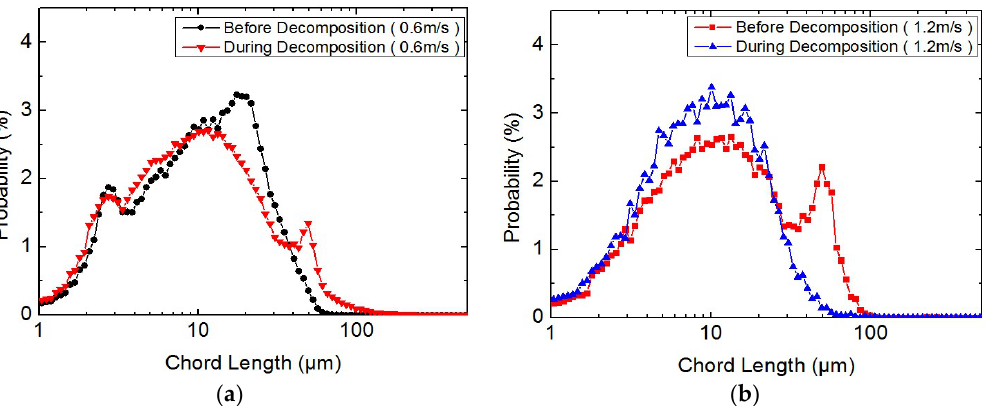
Figure 9. Influence of flow rate on chord length distribution during hydrate dissociation ( a , b ). ( a ) Influence of flow rate on chord length distribution (0.6 m/s); ( b ) influence of flow rate on chord length distribution (1.2 m/s).